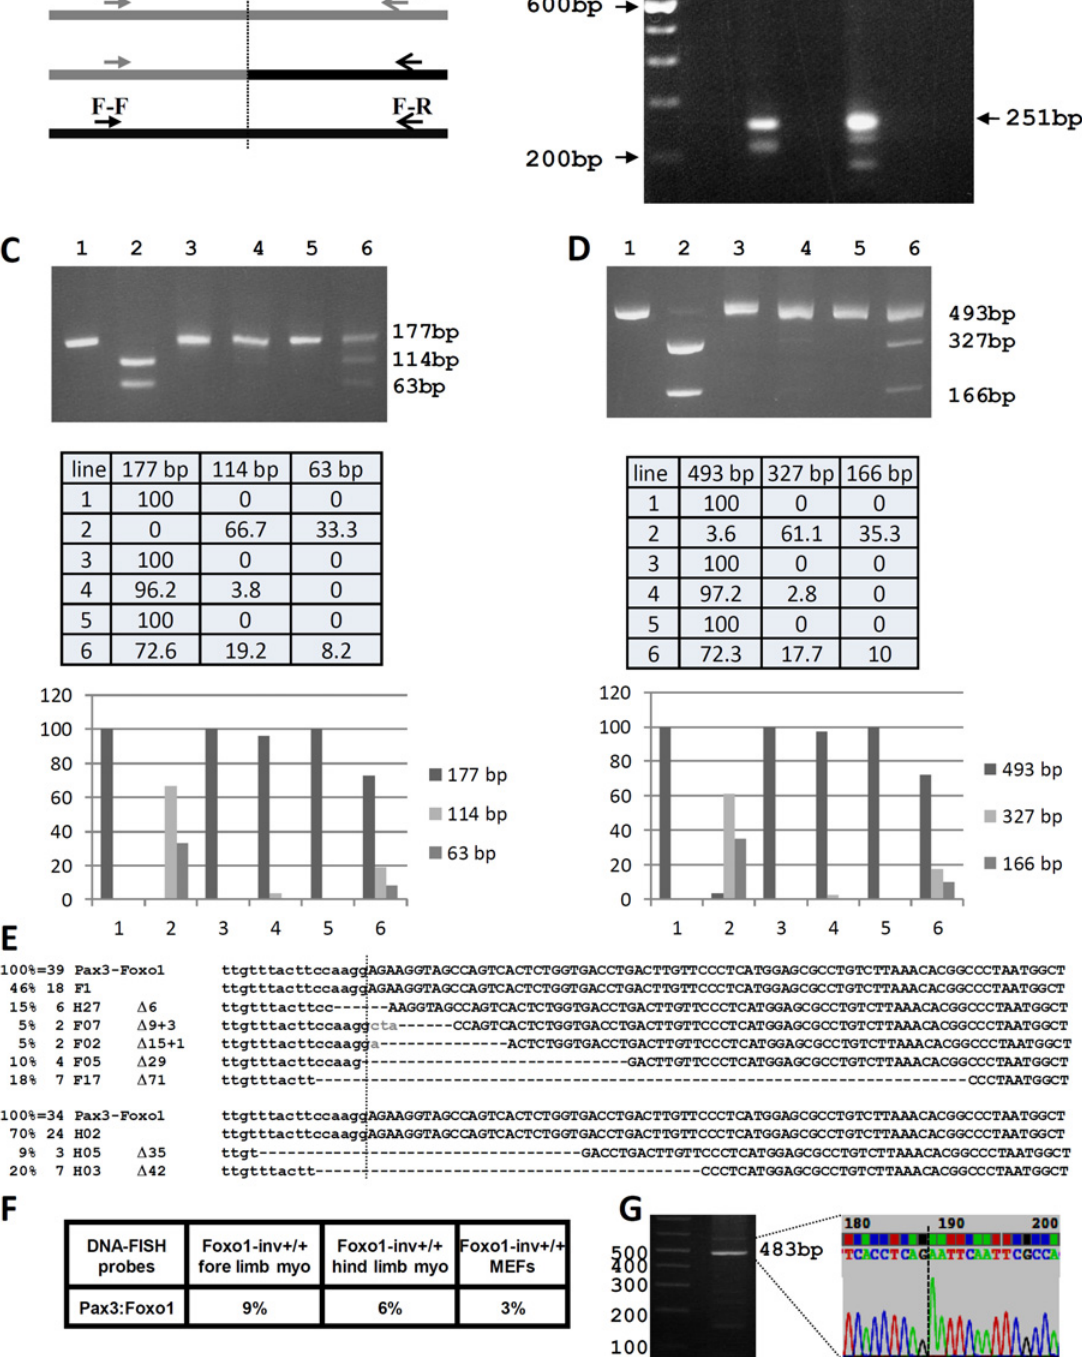
Figure 5. Analysis of the CRISPR-Cas9 induced t(1;3) in Foxo1-inv +/+ myoblasts. A. Schematic representation of the position of the Pax3 forward (P-F) and reverse (P-R) PCR primers upstream and downstream of the Pax3 breakpoint in intron 7 (DSB) and of the Foxo1 forward (F-F) and reverse (F-R) PCR primers upstream and downstream of the Foxo1 breakpoint in intron 1 (DSB). The P-F and F-R primer pair amplify the Pax3-Foxo1 fusion . B. Agarose gel showing the PCR products obtained using the P-F/F-R primer pair and DNA from Foxo1-inv +/+ hind limb DNA without (lane 1) and with (lane 2) CRISPR- Cas9 treatment, form Foxo1-inv +/+ fore limb DNA without (lane 3) and with (lane 4) CRISPR-Cas9 treatment, from wild type fore limb DNA with CRISPR-